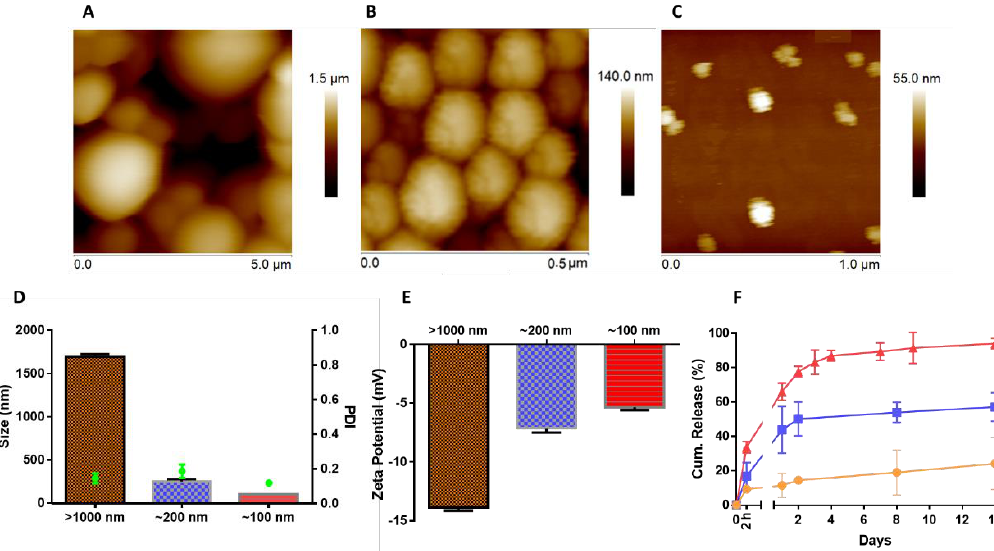
Figure 2. Atomic force microscopy height images of ( A ) > 1000 nm, ( B ), ~200 nm, and ( C ) ~100 nm PLGA particles. The scale bars display the Z-range and the scan sizes are shown on the x -axis. ( D )